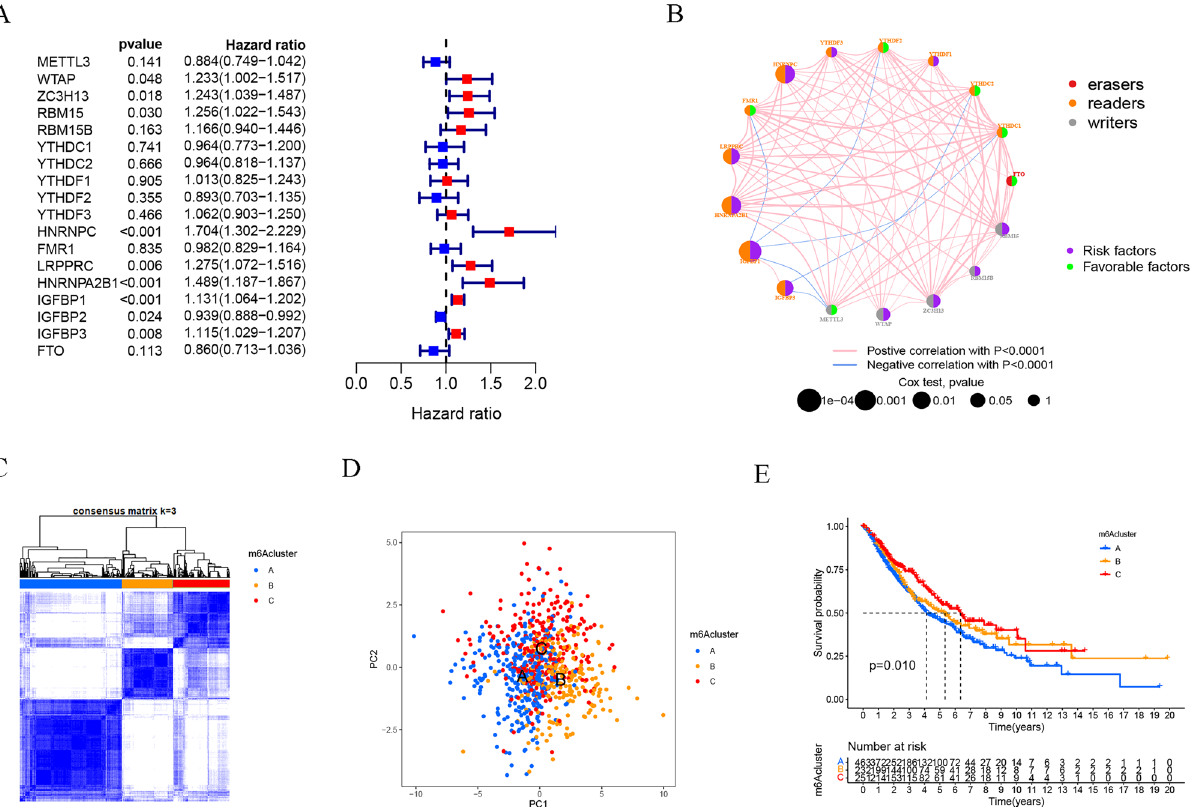
Figure 2. m 6 A RNA methylation modification patterns mediated by 23 regulators in LUAD. ( A ) Univariate Cox regression models were used to assess the prognoses based on 23 m6A regulators. ( B ) Interactions between m6A regulators in LUAD. The size of the circles represents the effect of each modulator on prognosis; larger circles represent a greater effect on prognosis (p-values: 1–0.0001). The association between the m6A regulators is shown by the connecting line; negative correlations are in blue and positive correlations are in pink. ( C ) Heat map of the matrix of co ‐ occurrent proportions for LUAD samples (K = 3). ( D ) Principal component analysis (PCA) analysis of m6A methylation modification pattern. ( E ) The overall survival of m6A methylation modification pattern using Kaplan–Meier